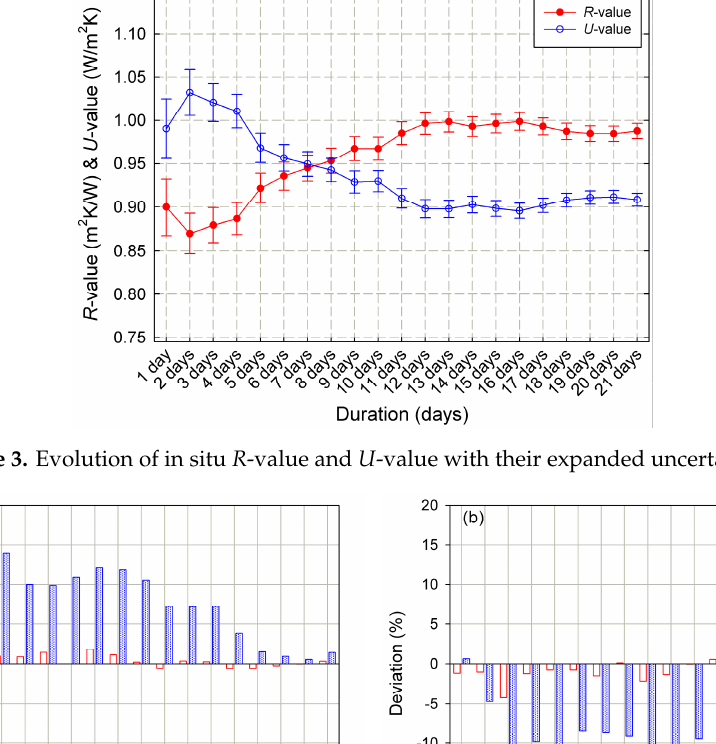
Figure 3. Evolution of in situ R -value and U -value with their expanded uncertainties.